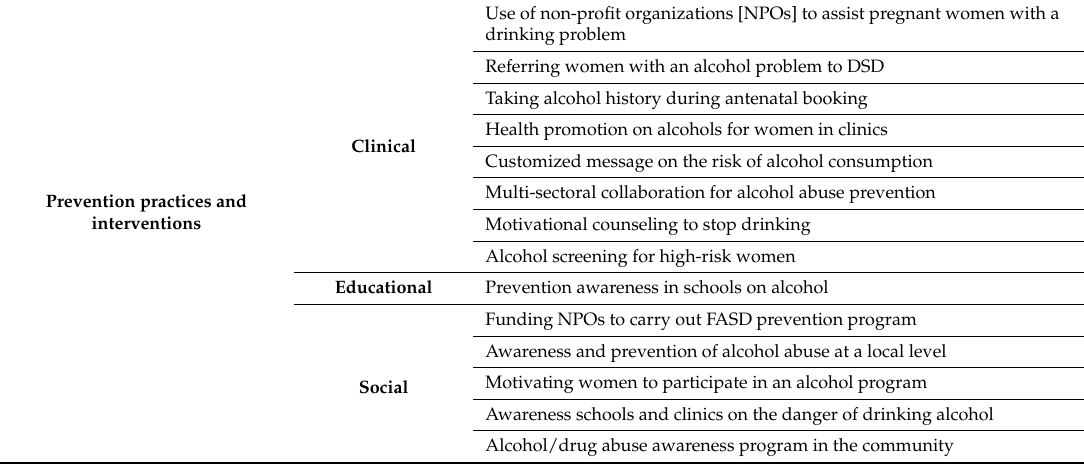
Table 2. Current practices and